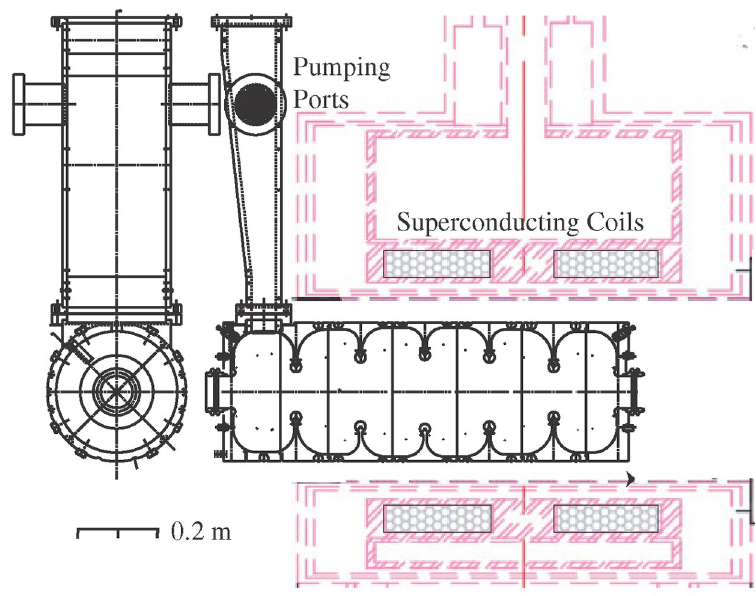
FIG. 1. (Color) The rf cavity in the superconducting